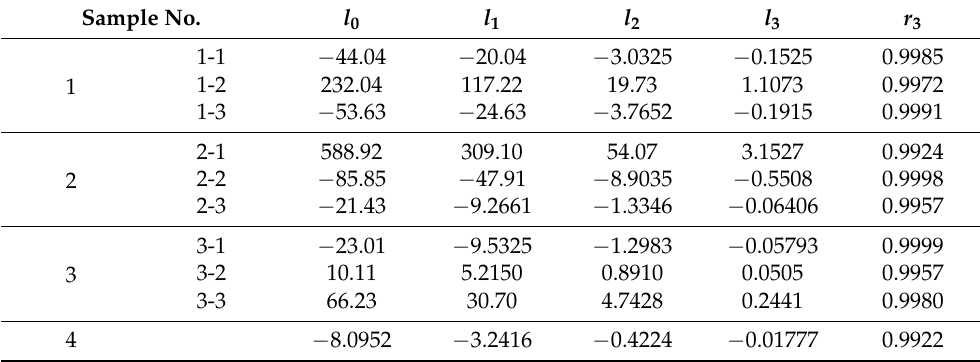
Table 8. Chemical-reaction and diffusion coefficients (third-order polynomial equation) at the later stage. Sample No. l